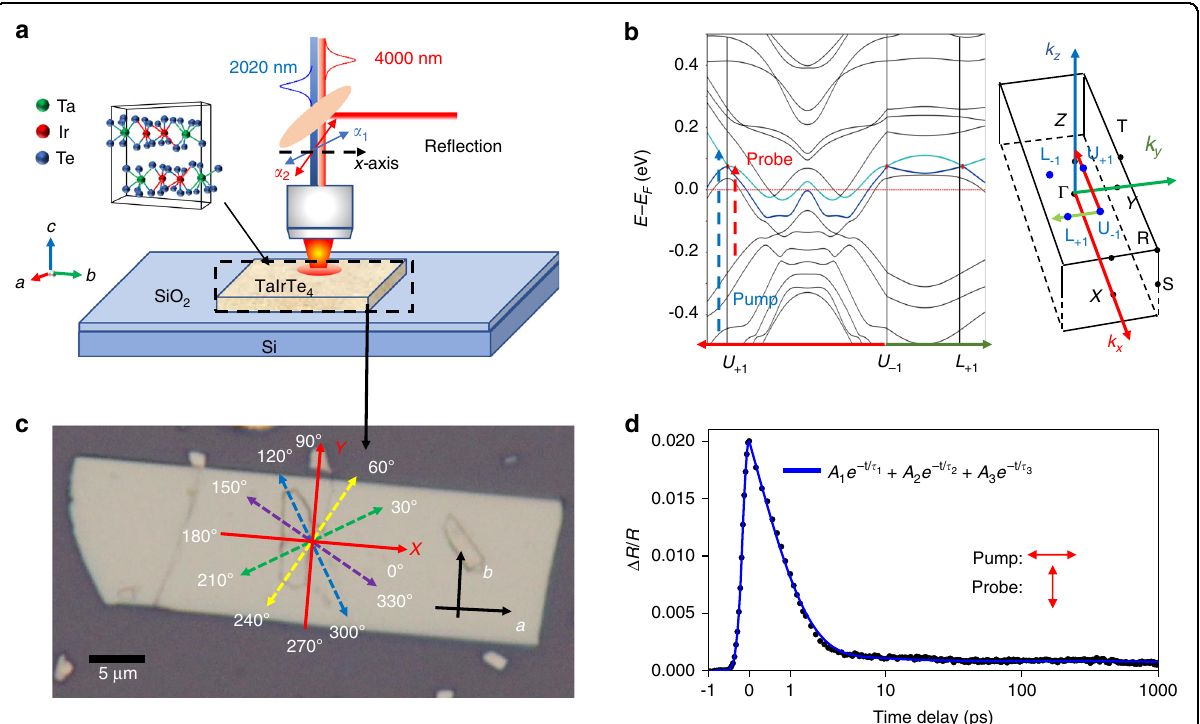
Fig. 1 Experimental scheme, lattice and band structure, optical image, and typical transient re fl ection spectrum. a Experimental scheme of pump-probe spectroscopy. b The two energy bands (blue and purple) nest four type-II Wyle points, U + , U – , L + , and L – , near the Γ in the Brillouin zone. Band diagram sampled along the U + -U - - L + direction, of TaIrTe 4 with the typical pump and probe photon transitions marked by blue and red arrows, respectively. c Optical micrograph of the TaIrTe 4 sample. d Transient re fl ection spectrums with cross-polarized pump (2020 nm) and probe (4000 nm) geometry. The curve is fi tted by Δ R/R = A 1 e (cid:1) t = τ 1 þ A 2 e (cid:1) t = τ 2 þ A 3 e (cid:1) t = τ 3 with τ 1 = 1.02 ± 0.01 ps, τ 2 = 4.04 ± 0.05 ps and τ 3 = 14.0 ± 1.8 ns (blue solid line). The temperature is 297 K and the pump power is 300 μ